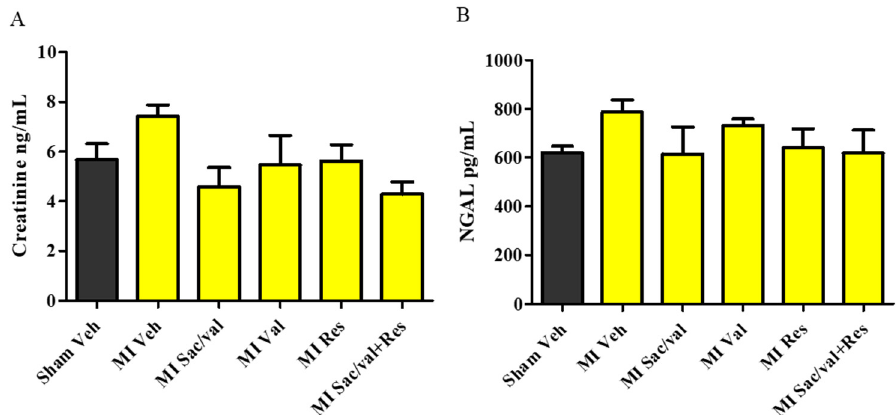
Figure 6. ( A ) Creatinine; ( B ) Neutrophil gelatinase associated lipocalin (NGAL) (plasma). All values are expressed as mean ± SEM, n = 4–6. Veh—vehicle, Sac/Val—sacubitril/valsartan, Res—resveratrol, Val—valsartan.